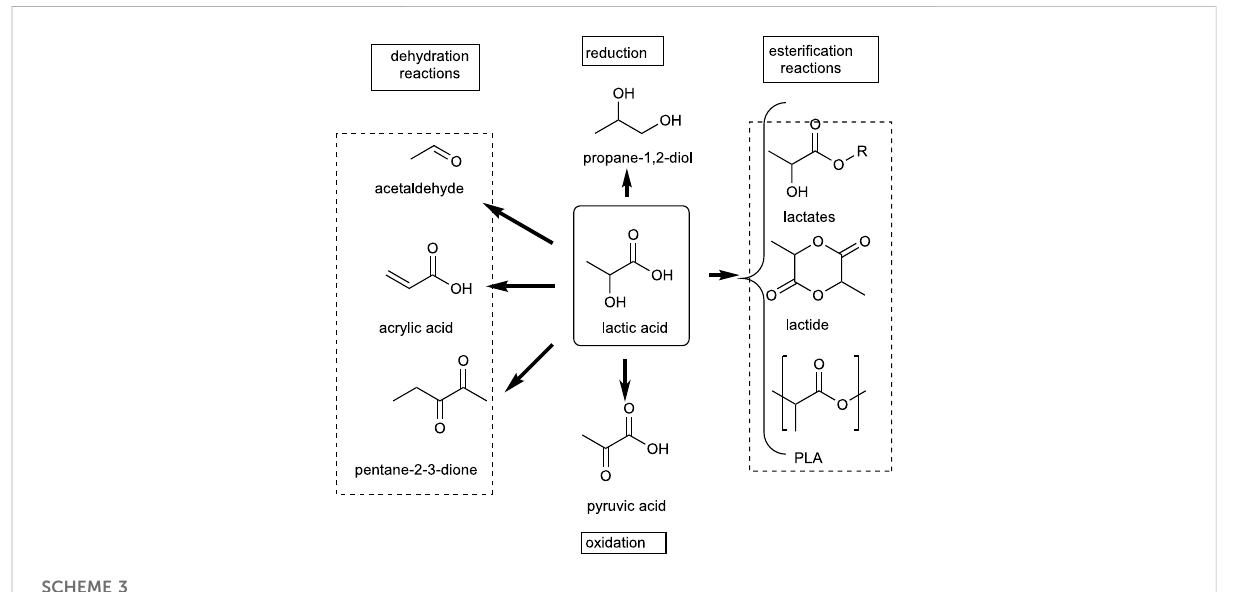
SCHEME 3 Valuable molecules that can be derived from lactic acid.